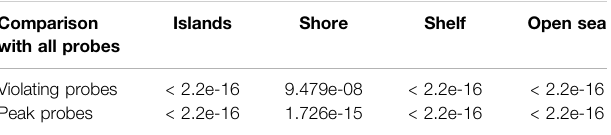
TABLE 4| p -valuesobtained bychi-squaredproportion tests on different types of discordant probes with the pool of all probes, strati fi ed by the CpG region. All results are signi fi cant at α (cid:1)